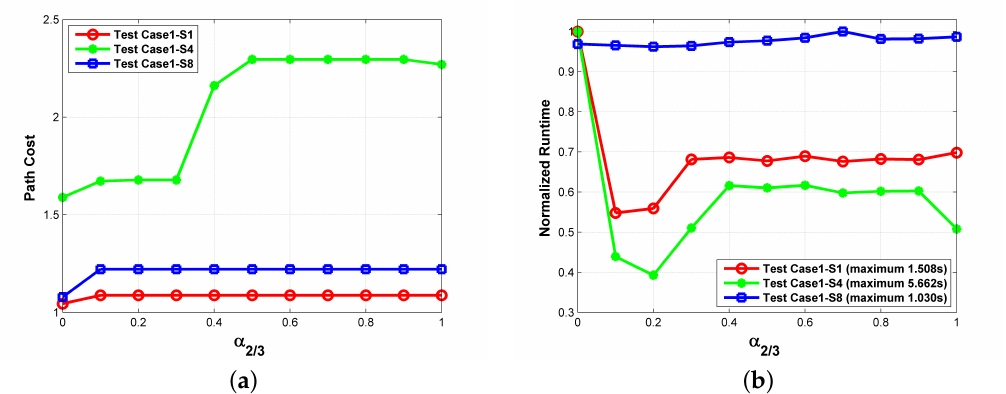
Figure 17. Influence of heuristic weights α k on the designed path. ( a ) influence on path cost; ( b ) influence on computational